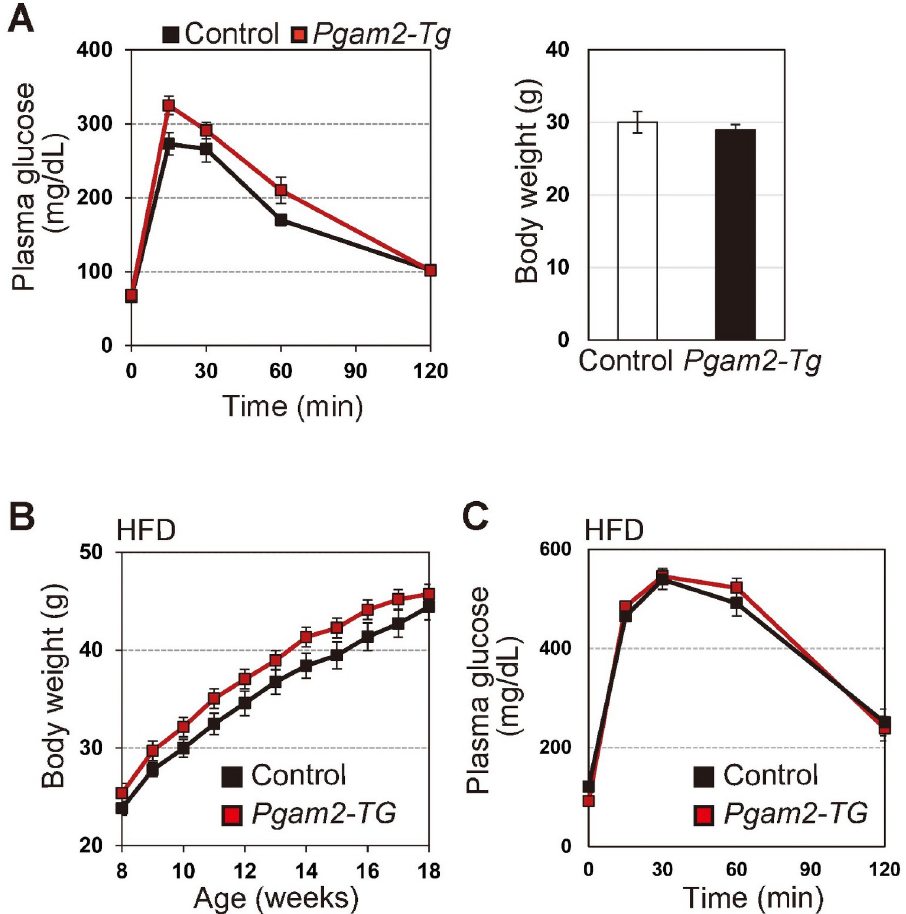
Fig 4. Glycolytic profiles in PGAM2-Tg mice. (A) Intraperitoneal glucose test (IPGTT) was performed in control (wild-type) ( n = 10) and Pgam2 -Tg mice ( n = 8) (Left panel). Body weight was measured at 18 weeks (Right panel). (B and C) High-fat diet (HFD) protocol was performed to induce obesity in control (n = 9) and Pgam2 -Tg mice (n = 7). (B) Body weight was monitored during the protocol (left panel). (C) IPGTT was performed in HFD-fed obese mice at 18 weeks (right panel). Data represent the mean ±